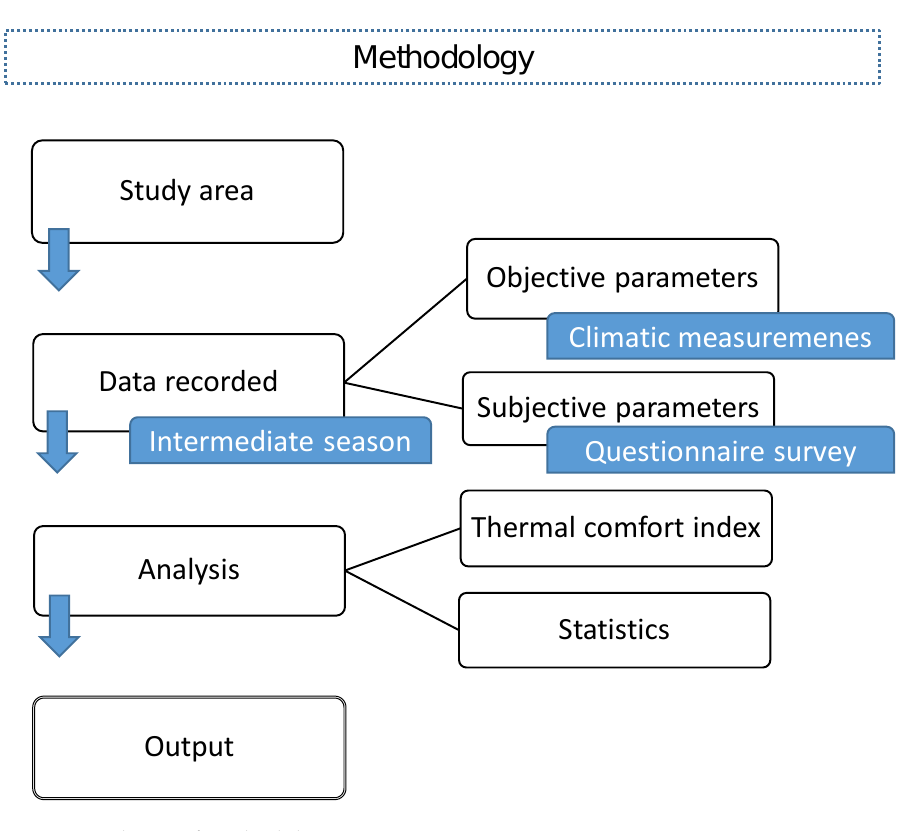
Figure 11. Scheme of methodology.